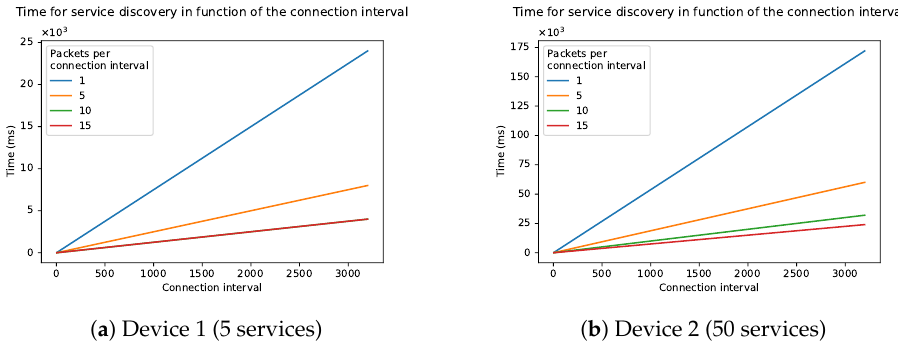
Figure 17. Time of the RSDP as a function of the connection interval of two devices: ( a ) Device 1 and ( b ) Device 2 with a limitation on packets per connection